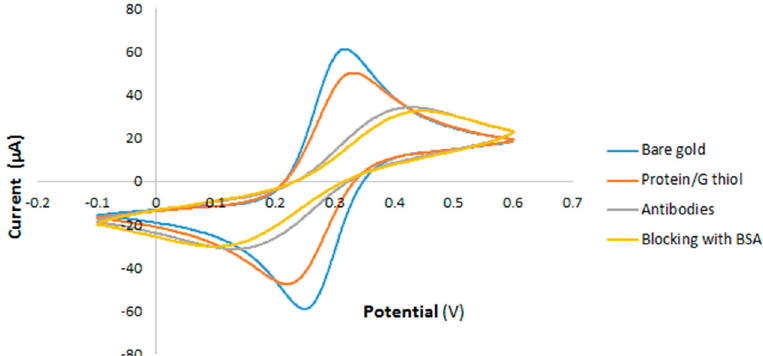
Figure 4. Cyclic voltammetry (CV) for the case of bare Au electrode (blue curve), added protein/thiol (red curve), immobilized anti- Cryptosporidium antibodies (gray curve), and added bovine serum albumin (BSA) (yellow curve).